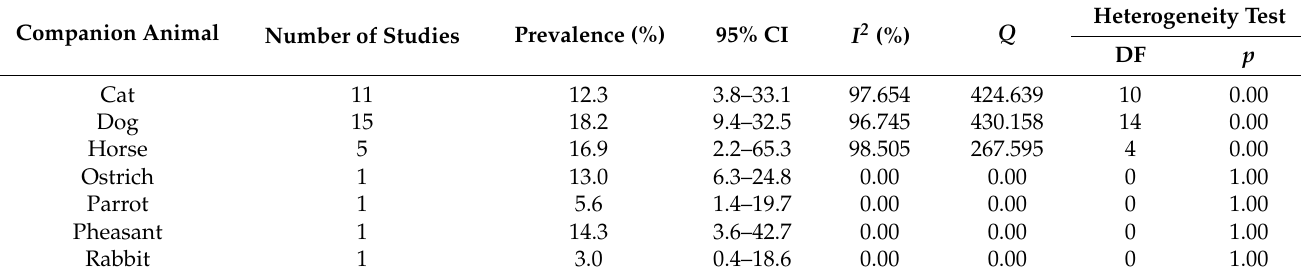
Table 3. Subgroup analysis for comparison of prevalence of VRE in companion animals according to the type of companion animal.